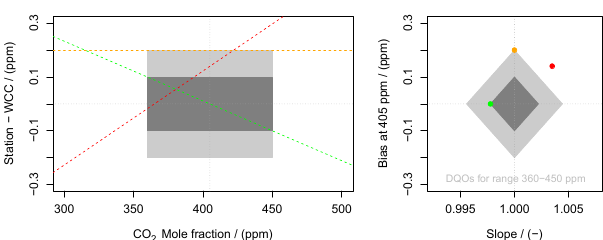
Figure 1. Left: deviation vs. reference value plot for CO 2 (illustra- tive) for three different cases (green, orange, red; details see text) for the mole fraction of 360–450ppm CO 2 . Right: illustrative bias vs. slope plot for the cases shown in the left panel (details see text). The grey areas correspond to the WMO/GAW compatibility (dark grey) and extended compatibility (light grey)